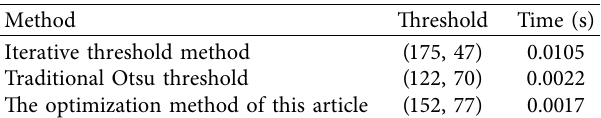
Figure 3: Algorithm comparison effect. Table 2: Three kinds of threshold processing time for bitmap images.